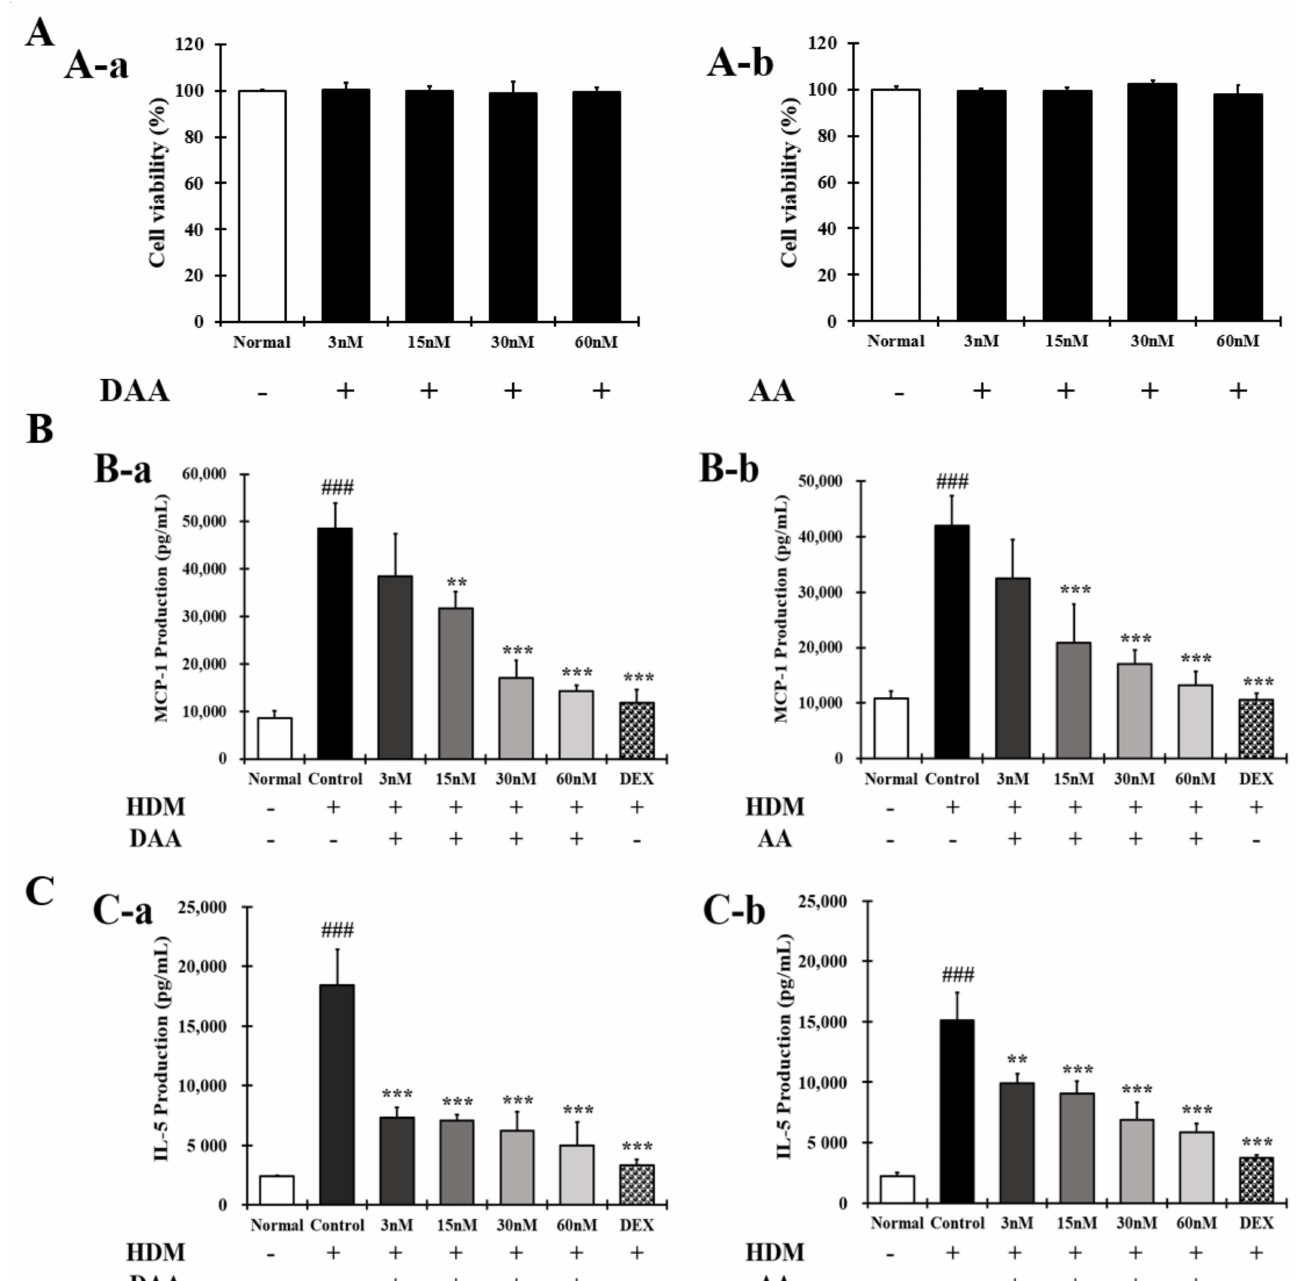
Figure 4. Effect of DAA and AA on the viability of EOL-1 cells and AD-related cytokines and chemokines secreted from EOL-1 cells. ( A ) Viability of EOL-1 cells treated with DAA and AA. ( B ) Inhibitory effects of DAA and AA on the levels of MCP-1 secreted from HDM-treated EOL-1 cells. ( C ) Inhibitory effects of DAA and AA on the levels of IL-5 secreted from HDM-treated EOL-1 cells. The levels of cytokines and chemokines in the supernatant of EOL-1 cells were determined by ELISA. The results are expressed as the mean ± SD (n = 4). ### p < 0.001 vs. normal. ** p < 0.01, *** p < 0.001 vs. control; DAA was used at 3 nM, 15 nM, 30 nM, and 60 nM. DEX, the positive control, was used at 2